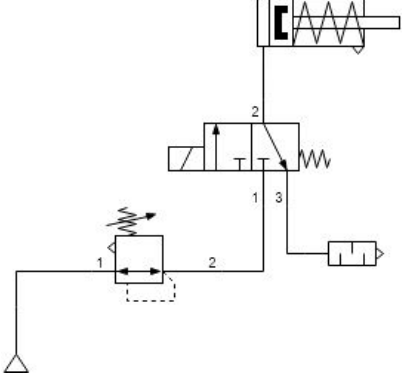
Figure 3. Pneumatic scheme of the robot .